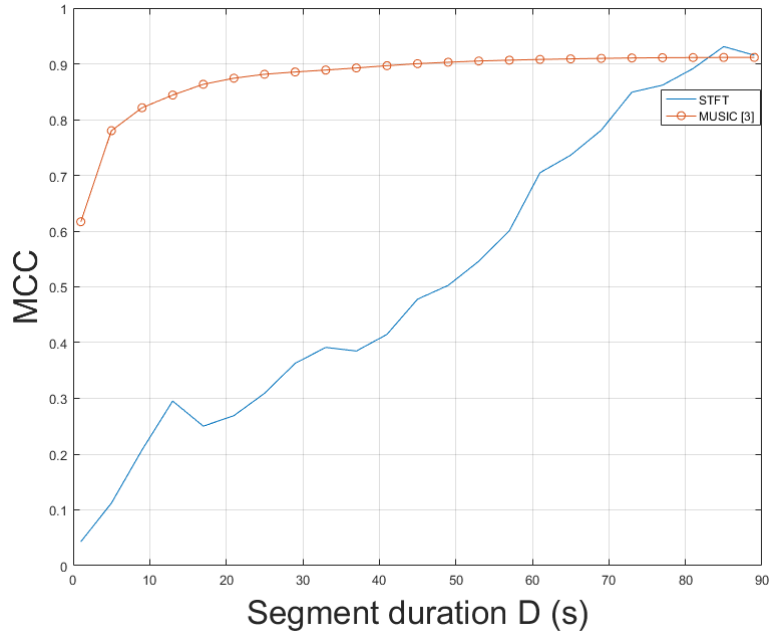
Figure 12. Maximum correlation coefficient of the proposed approach employing SLIC+STFT for various segment durations against the MUSIC [3] (mov6).